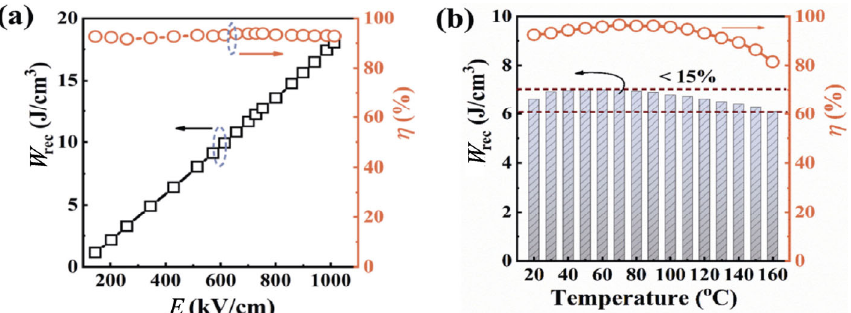
Fig. 33 Energy-storage performance of NBT–SBT–0.08BMN capacitors at (a) room temperature and (b) various temperatures. Reproduced with permission from Ref. [143], © Published by Elsevier B.V.